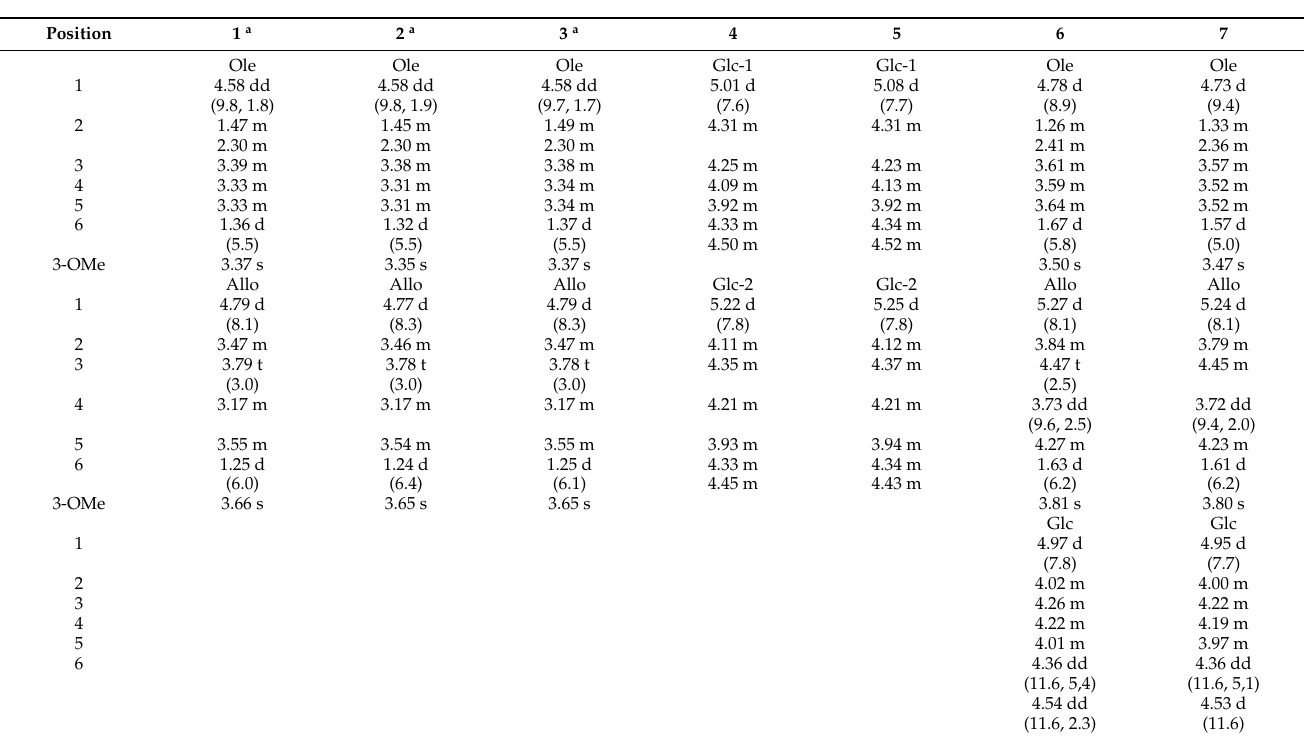
Table 3. 1 H NMR data of the sugar moieties of compounds 1 – 7 in pyridine- d 5 (500 MHz, δ in ppm, J in